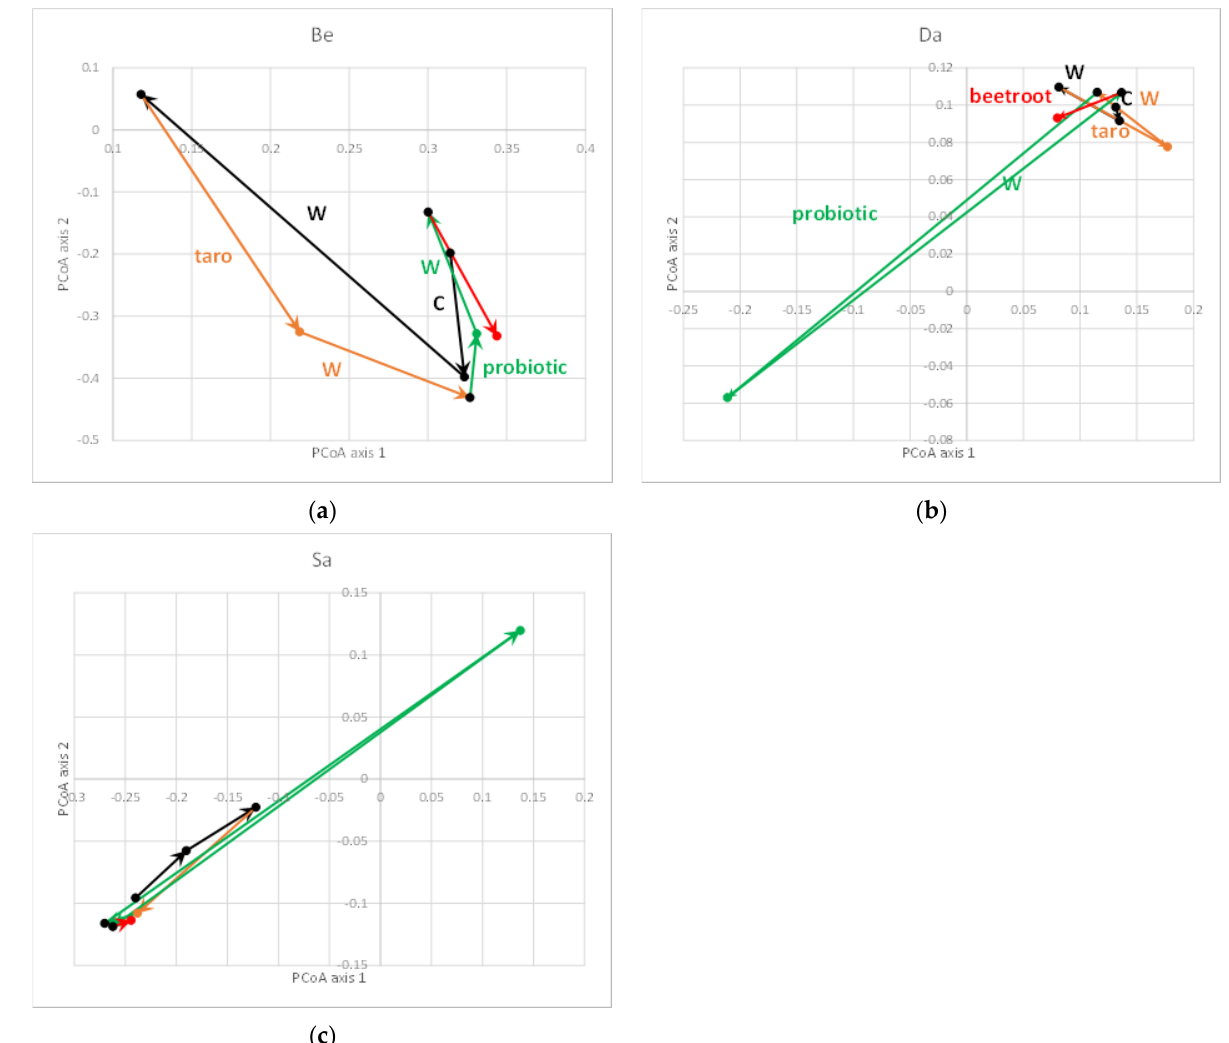
Figure 5. Trajectories of three individuals from Figure 4b with the largest changes. Individual Be ( a ) with large changes during the wash-out (W) period after the run-in period (C); ( b , c ) individuals Da and Sa, respectively, with large changes during the probiotic treatment. Samples are color-coded as follows: black: run-in period and corresponding wash-out (all baseline datapoints are colored black as well assuming that the microbiota went back to baseline after the wash-out); orange: taro treatment and corresponding wash-out; green: taro + probiotic treatment and corresponding wash-out; red: taro + beetroot treatment. Arrows indicate the sequence of treatments and the trajectory of the β -diversity changes. Axis 1 explains 18.9% and axis 2 8.5% of the variability between samples, respectively.